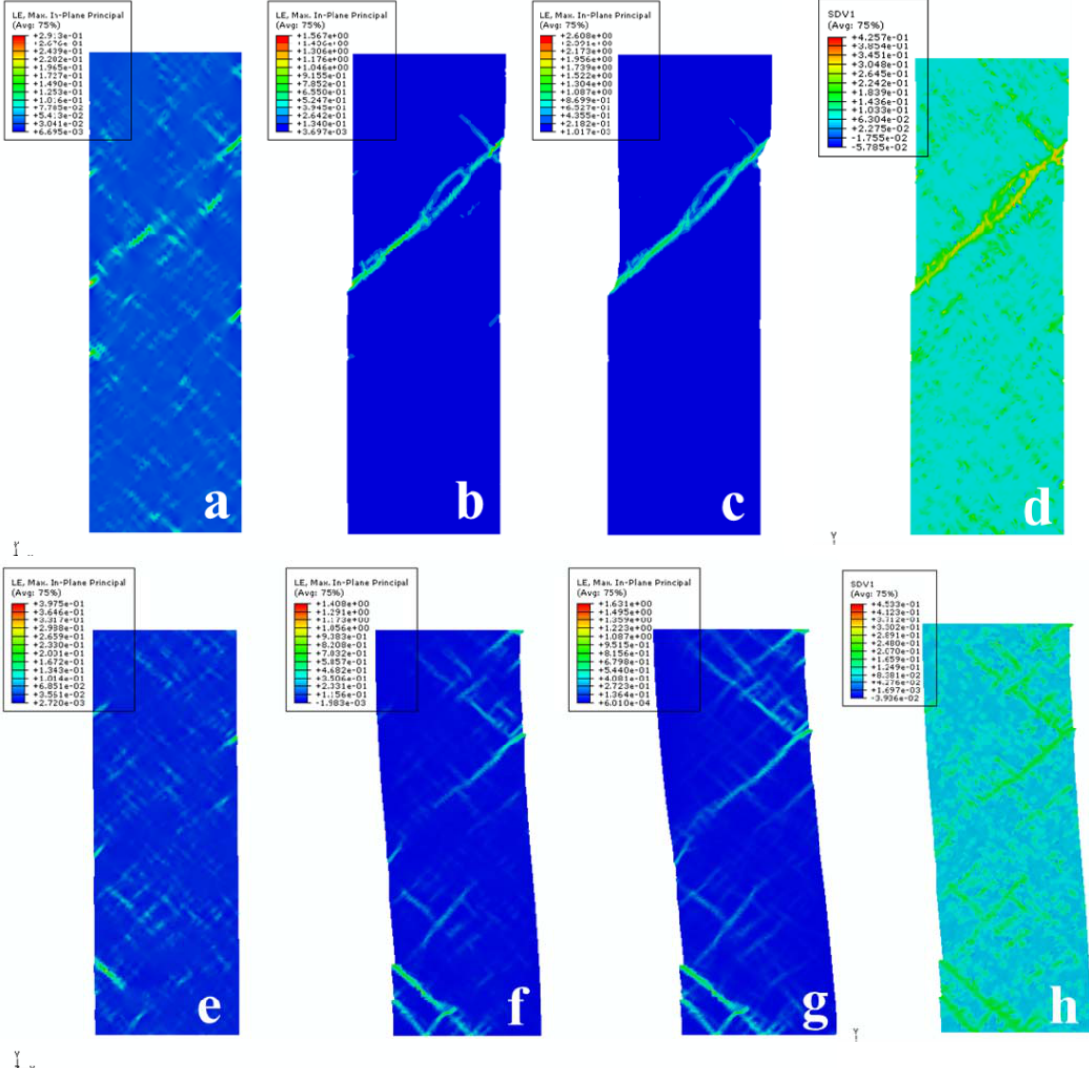
Figure 5. Shear band formation in the plane strain tension ( a – c ) and compression ( e – f ) using the J model. Strain contours for tension are shown at ( a ) time t = 3.5361 × 10 4 , the initiation 2 of shear localization, ( b ) t = 3.5385 × 10 4 , the yielding point, and ( c ) t = 3.6406 × 10 4 , at the end of the shear localization. Strain contours for compression are shown at ( e ) t = 3.4623 × 10 4 , the initiation of shear localization, ( f ) t = 34676 × 10 4 , the yielding point, and ( g ) t = 3.8493 × 10 4 , the end of the shear localization. The corresponding spatial distributions of the free volume at the yield point are plotted in ( d ) for tension and ( h ) for